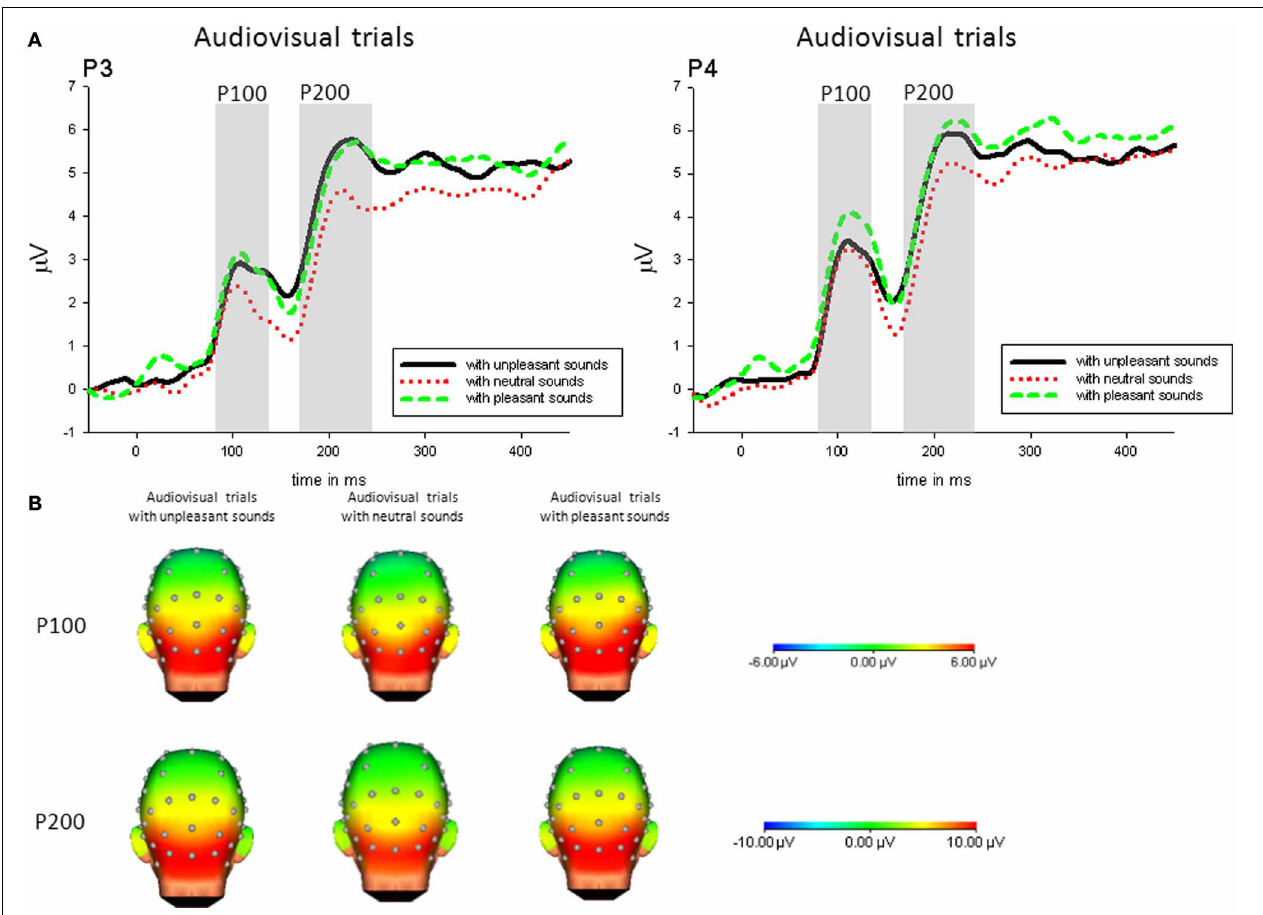
FIGURE 2 | (A) ERPs (in μ Volt) for representative channels (P3, P4) in response to all pictures (collapsed across unpleasant, neutral, and unpleasant pictures) with pleasant, neutral and unpleasant sounds. Gray boxes show the